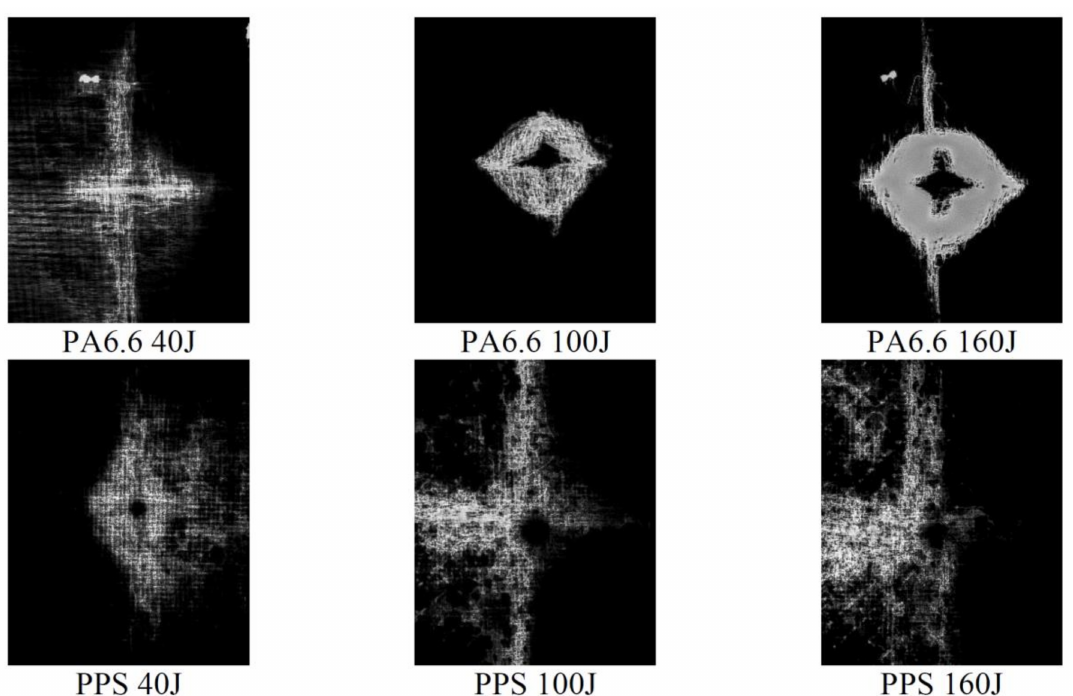
Figure 5. X-ray images of the specimens after impact.